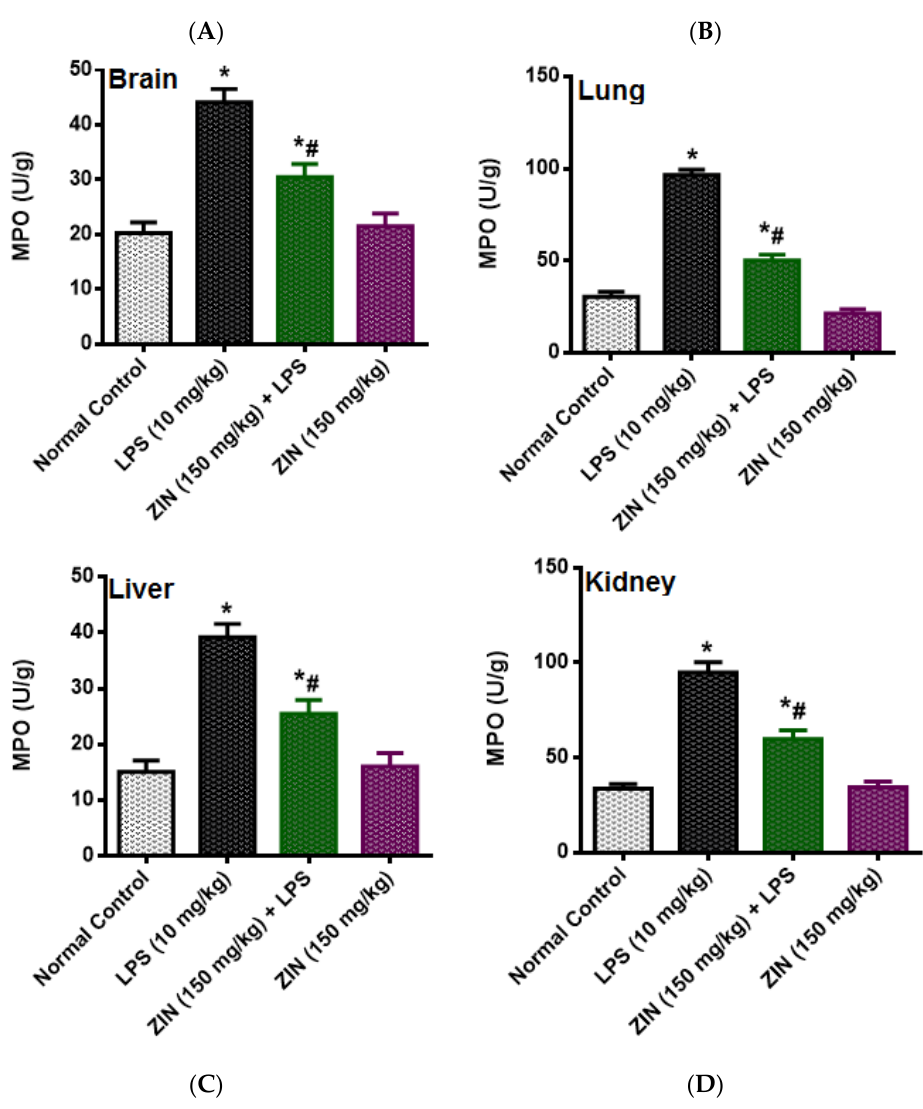
Figure 6. Effect of zingerone (ZIN) on LPS-induced oxidative stress as MPO (U/g). ( A ) Brain, ( B ) lung, ( C ) liver, and ( D ) kidney. Results are represented as mean ± SEM of six rats/group. * p < 0.05 vs. control; # p < 0.05 vs. LPS group.